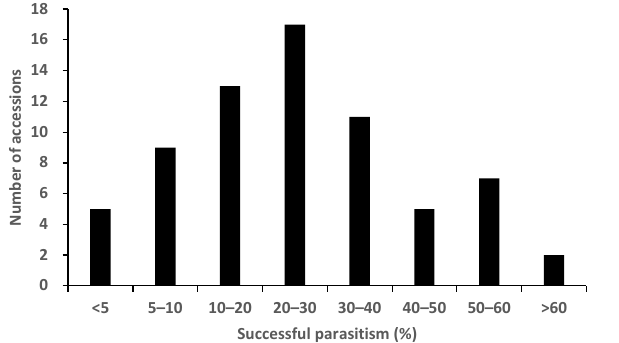
Figure 4. Frequency distribution of 69 accessions in World Rice Core Collection for percentage of successful parasitism (post ‐ attachment resistance).